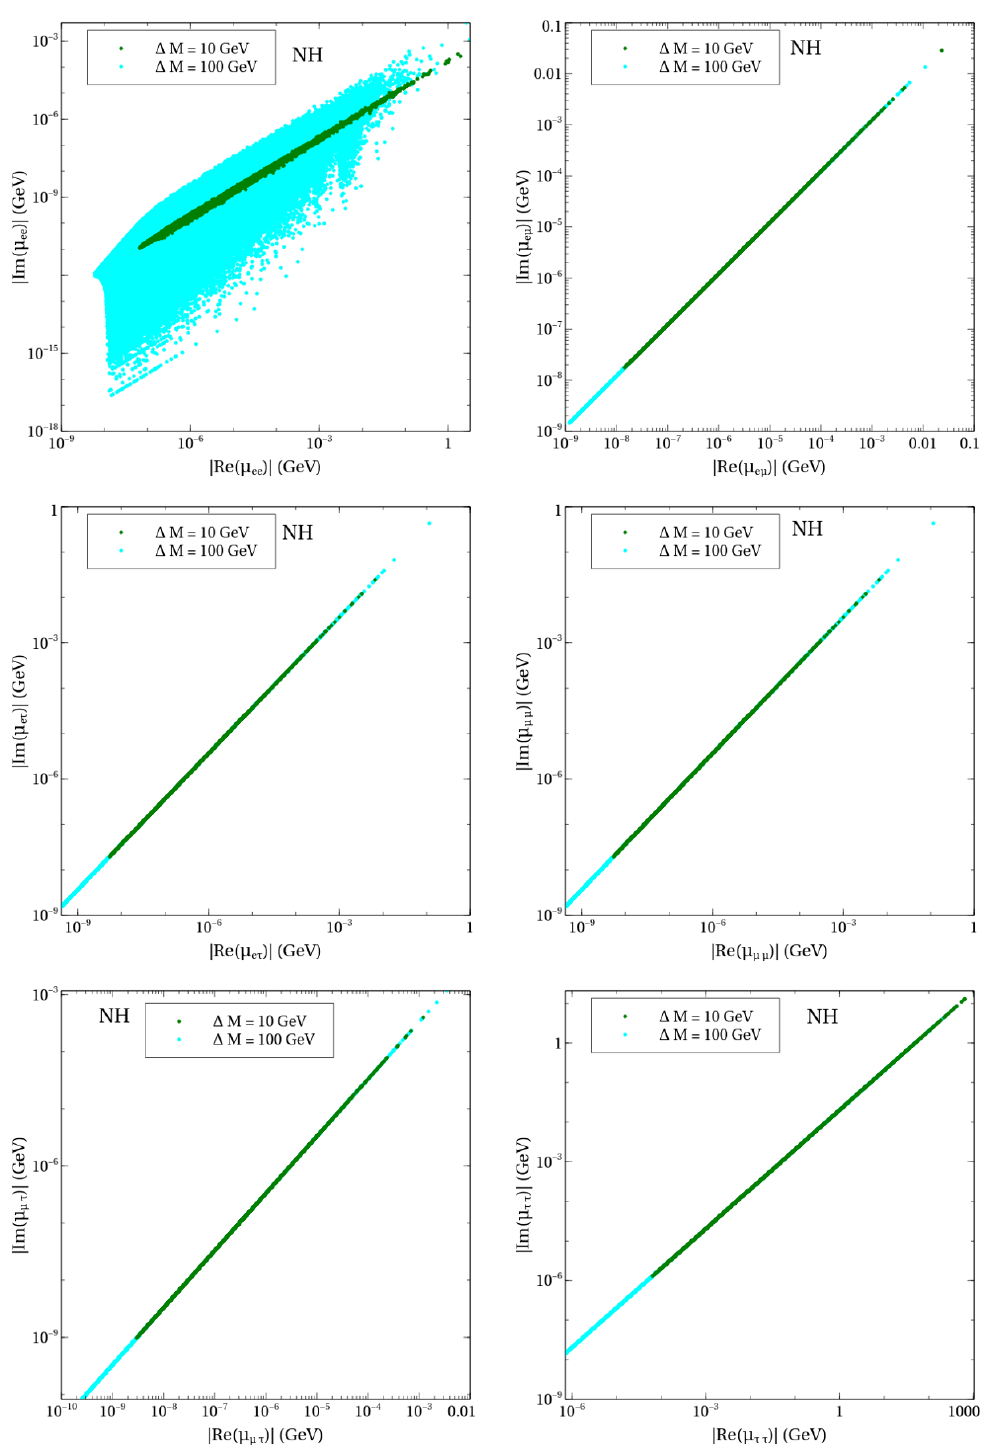
Figure 7 . Allowed values of (cid:22) (cid:11)(cid:12) in the case of normal hierarchy (NH), plotted in the plane of real vs imaginary axes. The color coding can be read from the legends.